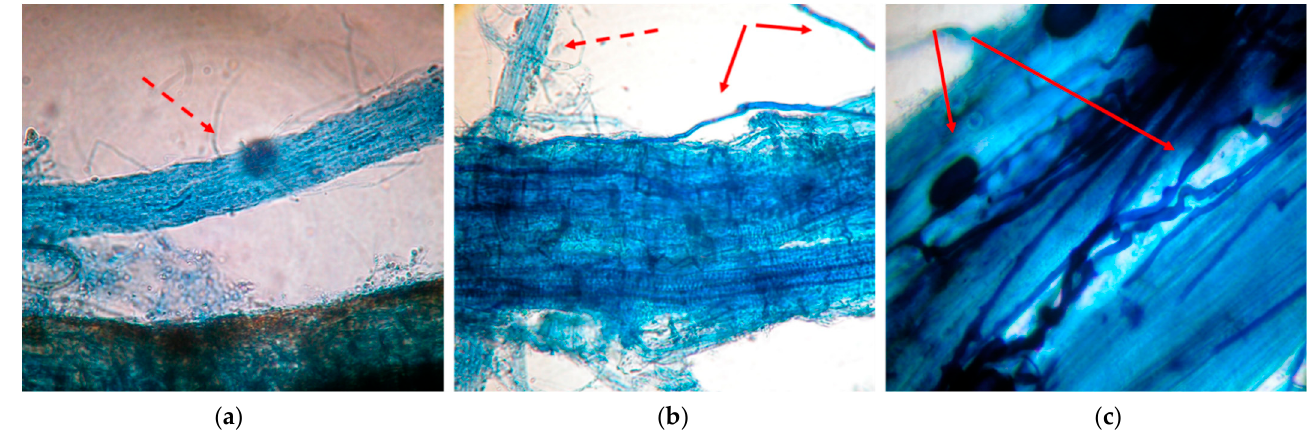
Figure A1. Experimental field: ( a ) immediately after transplanting; ( b ) three growing seasons after transplanting.